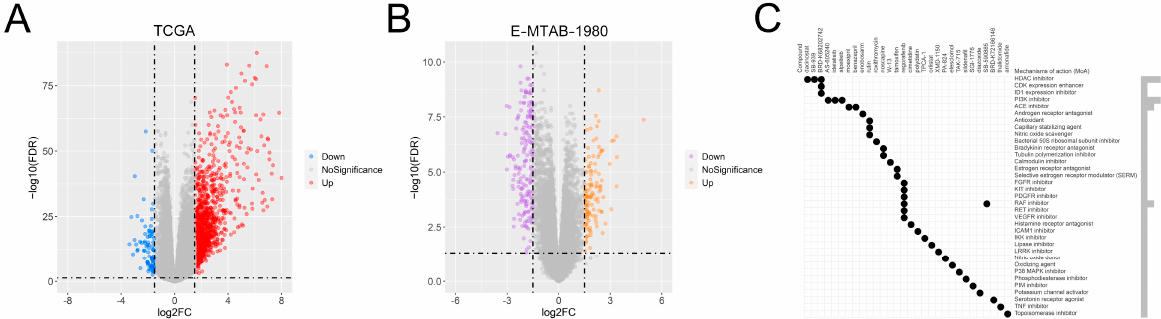
Figure 11. Prediction of potential drug molecules. ( A ) DEGs between both risk groups in the TCGA dataset. ( B ) DEGs between the two groups in the E-MTAB-1980 dataset. ( C ) Top 30 potential therapeutic targets and the corresponding MoAs.